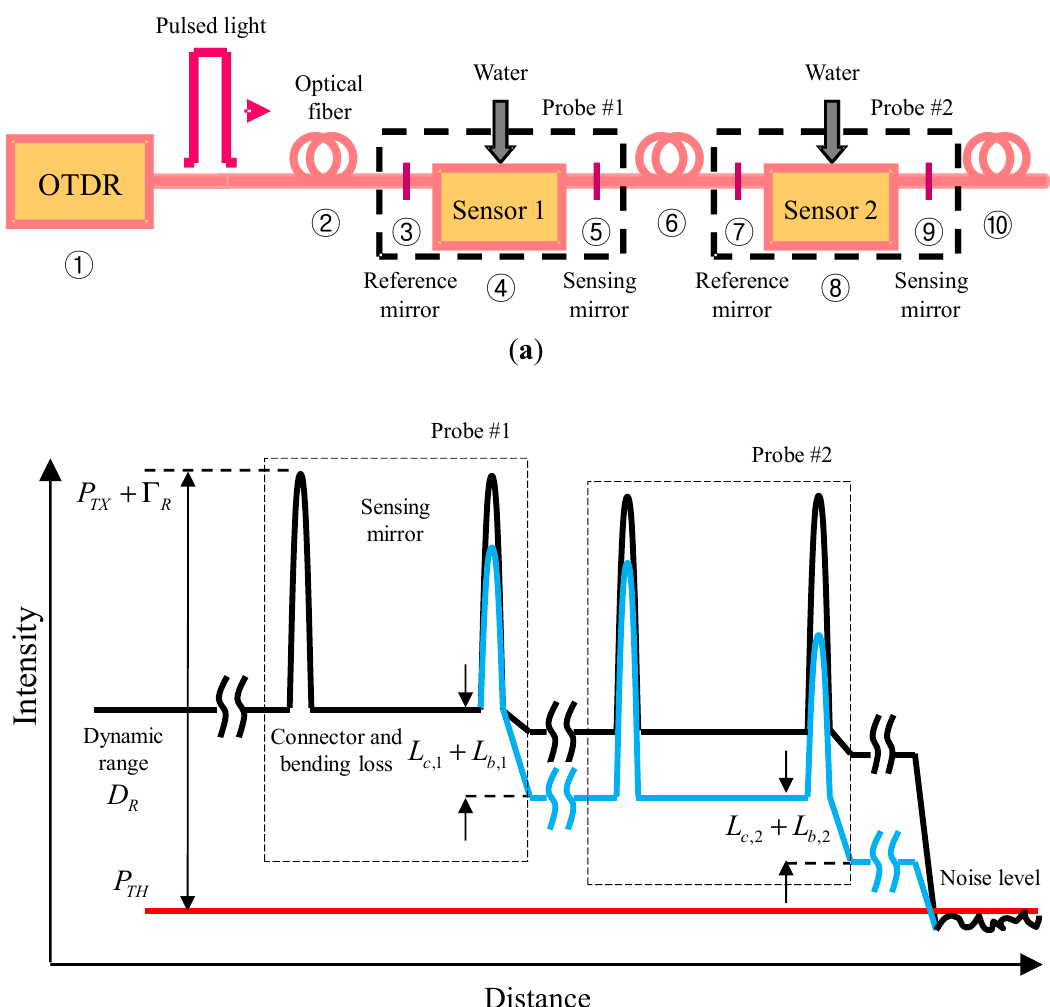
Figure 1. Schematic diagram of MOL-FOS using OTDR. ( a ) Configuration of MOL-FOS, WCS: Water combination soil; ( b ) The intensity of the received